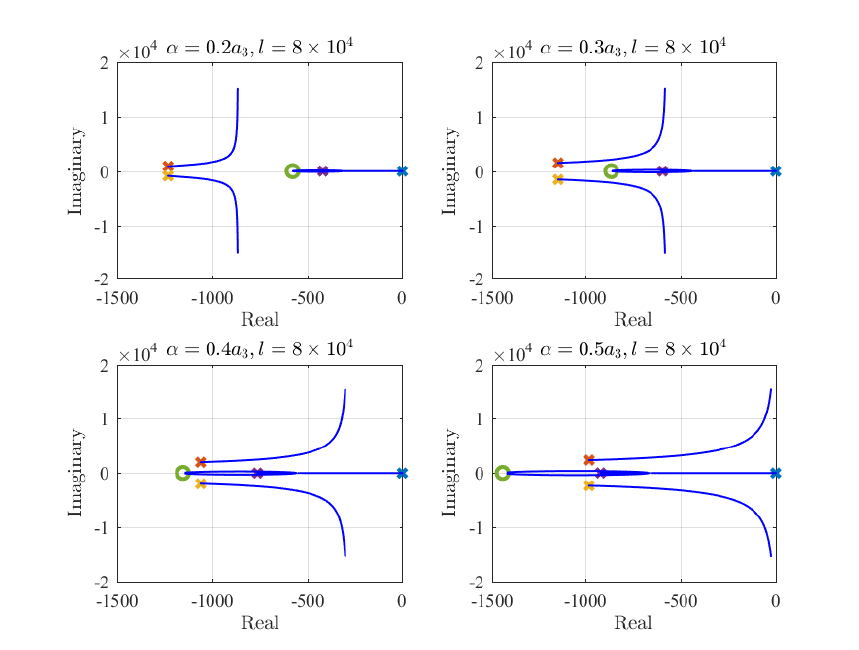
Figure 12. Root trajectories of ROPIO compensated ROMBC by increasing α with l = 8 × 10 4 . From the simulations carried out so far, it is concluded that the desirable performance obtained from the ROMBC is by using a value of α near 0.4 a 3 (black broken line plot in Figure 11). At this value of α , the state feedback controller produces a satisfactory transient performance while not risking instability caused by high-gain